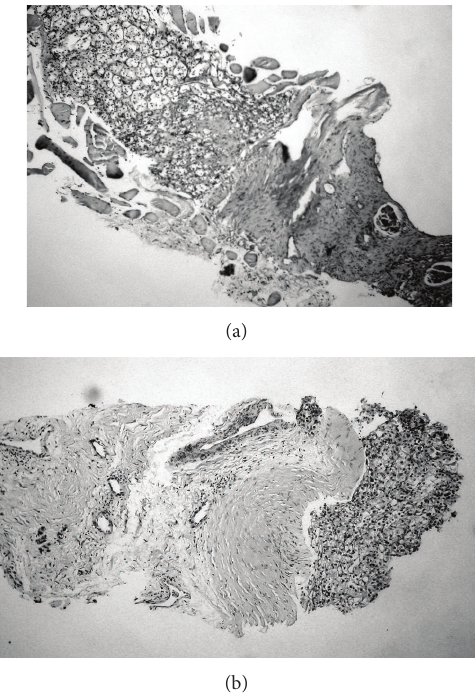
Figure 1: Abdominopelvic CT: (a) image showing 8cm large mass on the left kidney and (b) CT image demonstrating 11 × 11 ×8.5 cm giant gluteal mass causing the destruction of the iliac bone and acetabulum.